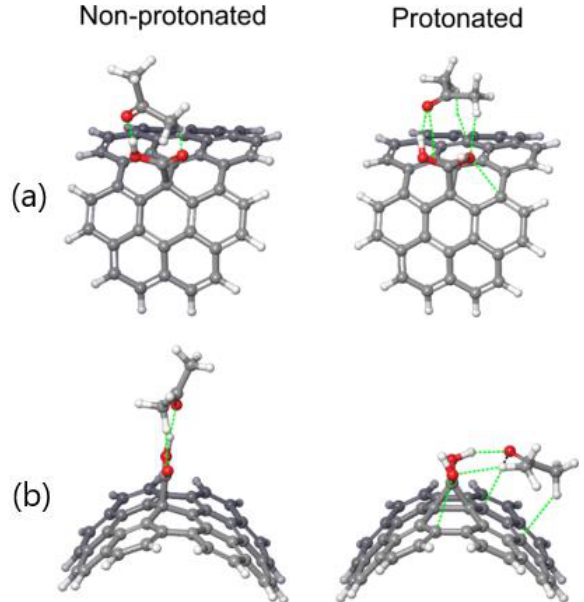
Figure 4. Noncovalent interactions (green dotted line) between SWCNT-COOH/pSWCNT-COOH and acetone ( a ) top and ( b ) side views, as obtained with the B3LYP-D3/6-31G(d,p) level of theory.